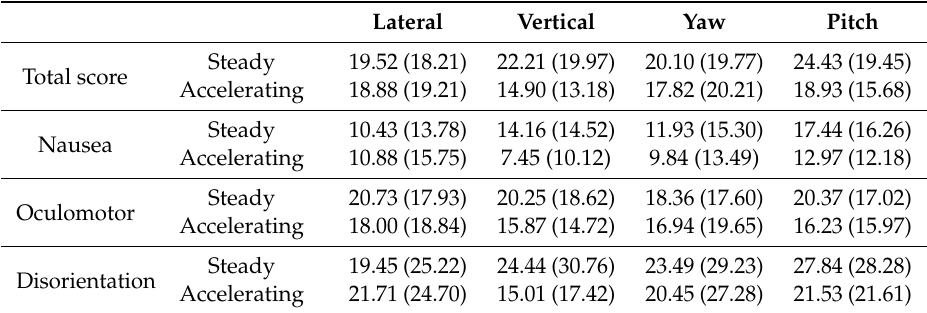
Table 5. Mean (standard deviation) of the SSQ scores for the severity level of